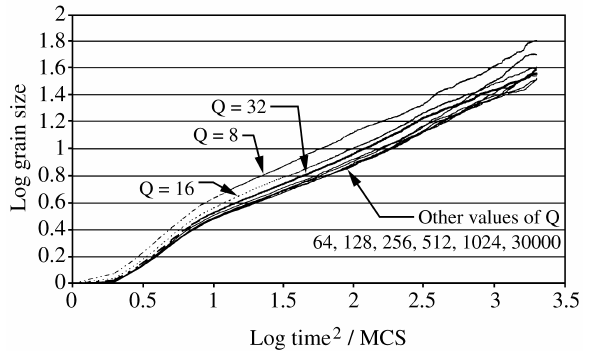
Figure 6. Grain growth behavior for increasing q values.